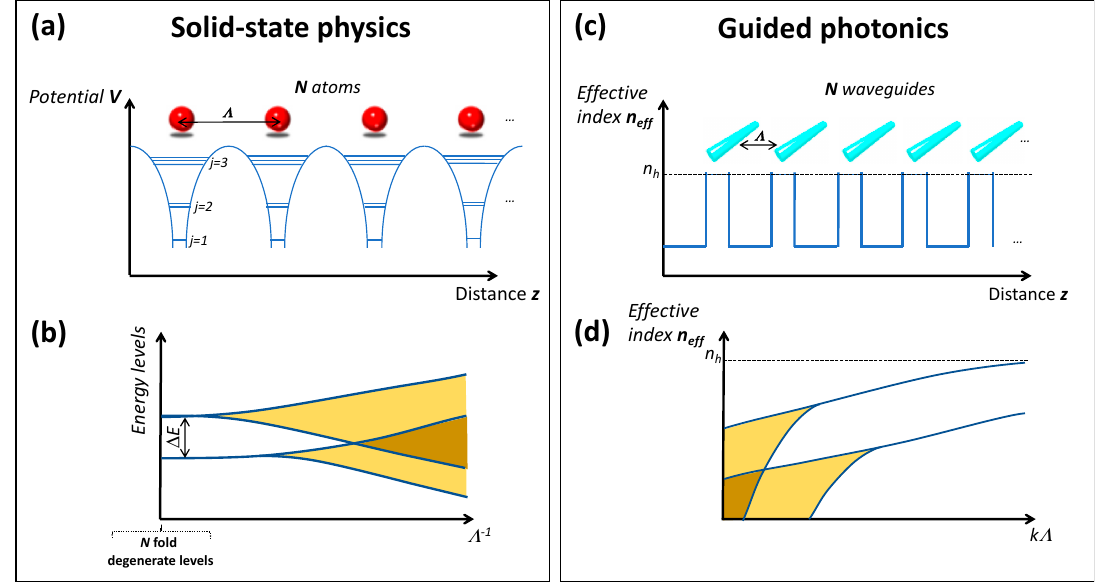
Figure 6. Analogy illustration between the Tight Binding model in an atomic structure and the Photonic Tight Binding model in an optical waveguide structure.